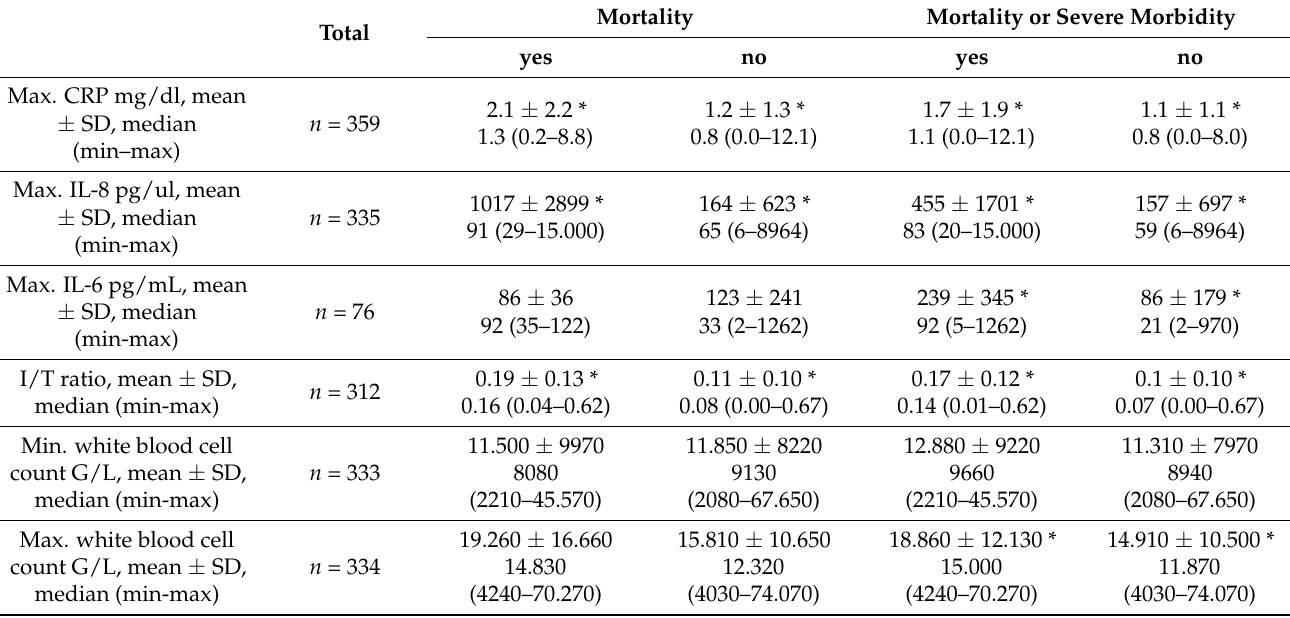
Table 4. Correlation of mortality and mortality or severe morbidity with neonatal laboratory test results ≤ 72 h of life.